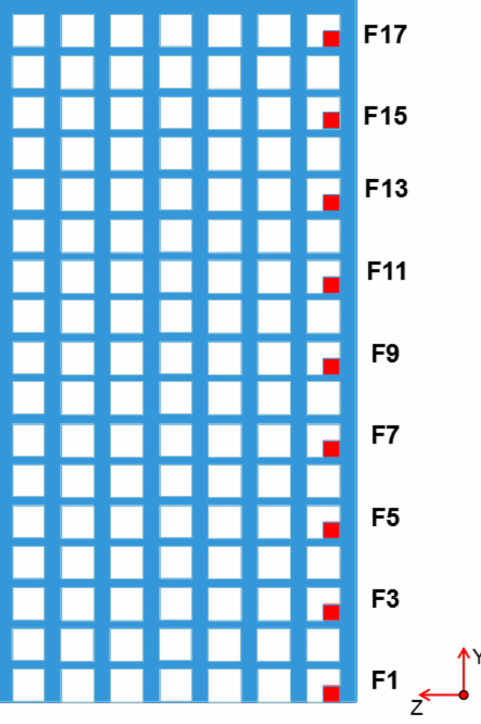
Figure 6. Monitoring points of